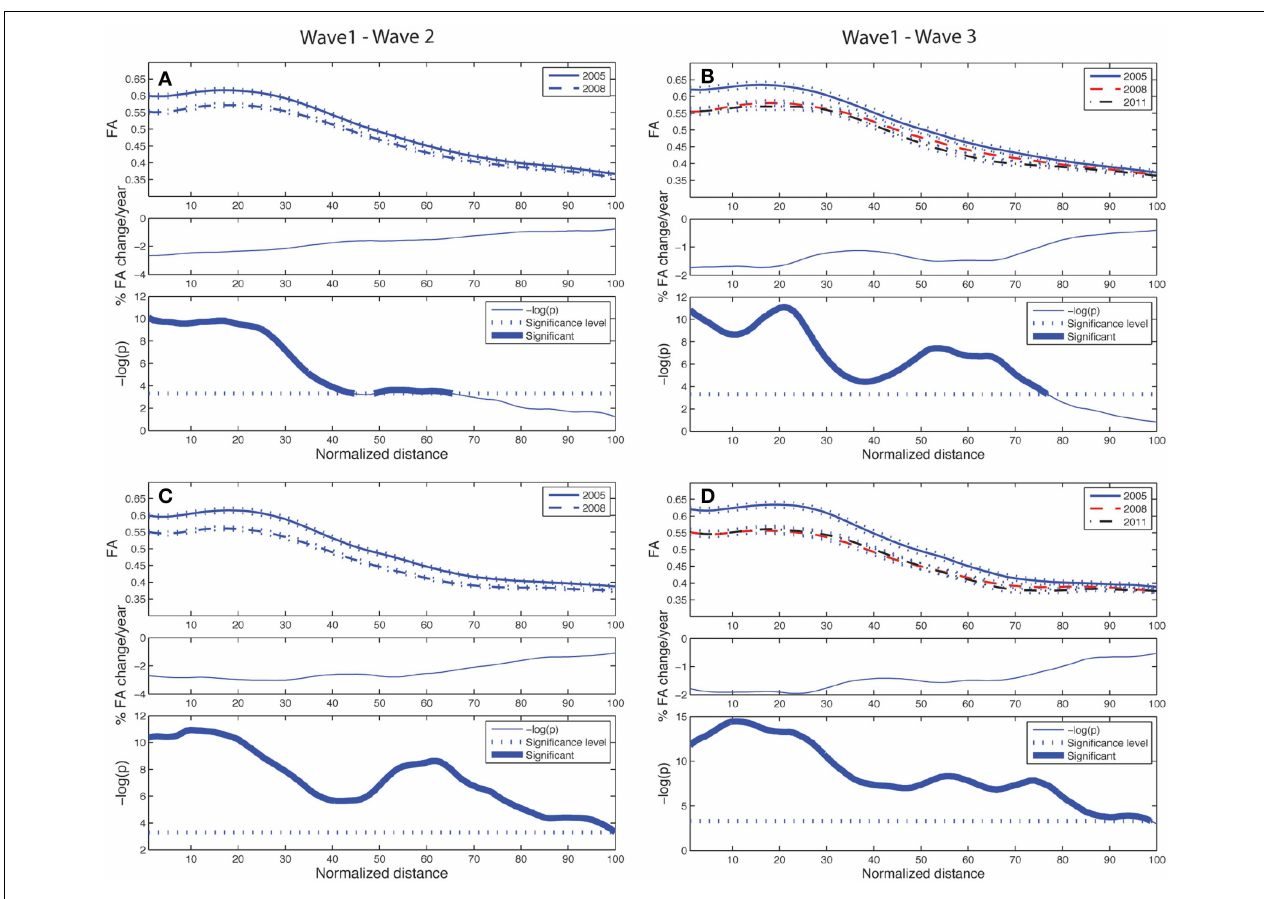
FIGURE 4 | Tract parameterization of the ACF for the two-wave (left column) and the three-wave (right column) analyses. The individual trajectories of the ACF is normalized into 100 equidistant segments, starting in the genu of corpus callosum (segment 1) traversing to the left and right prefrontal WM areas, respectively (segment 100). (A) Upper panel: Mean FA ± SE (dotted lines) profile of left hemispheric branch of ACF at Wave-1 (continuous line) and Wave-2 (broken line). Middle panel: Segment-wise percentage change in mean FA per year in the cohort from Wave-1 to Wave-2. Lower panel: Segment-wise significance in mean FA difference between Wave-1 and Wave-2 in the cohort. The p -value is scaled as − log ( p ) . Fat parts of the line denote ACF segments with statistically